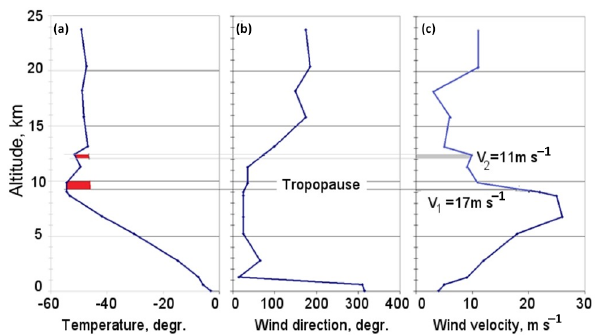
Figure 2. Vertical profiles of temperature (a) , wind direction (b) and wind velocity (c) according to the data of Kluchi meteorological observatory at 12:00UT on 16 November 2014.